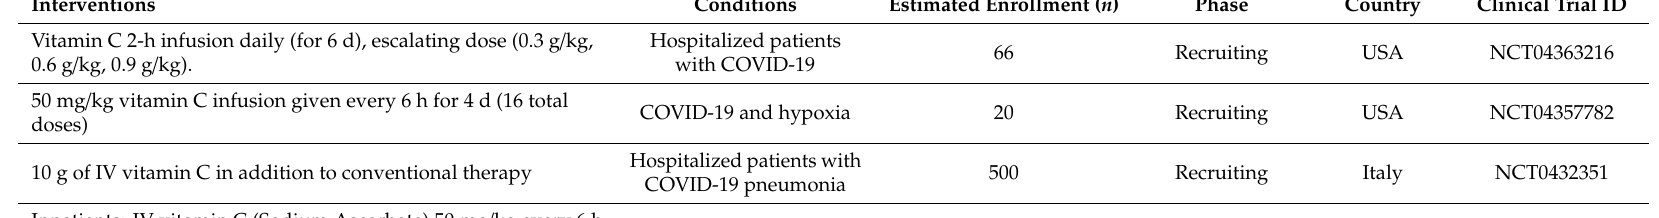
Table 1. Ongoing pharmaconutrition-related trials, as registered on https: // clinicaltrials.gov / . Search carried out on 4 August 2020. Interventions Conditions Vitamin C 2-h infusion daily (for 6 d), escalating dose (0.3 g / kg, 0.6 g / kg, 0.9 g /